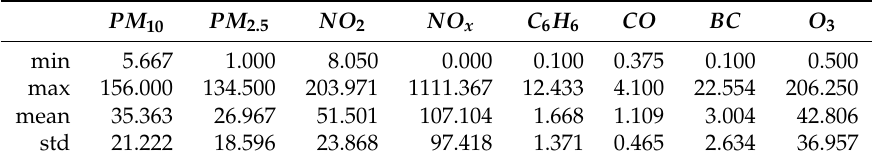
Table 8. Descriptor values for target variables.